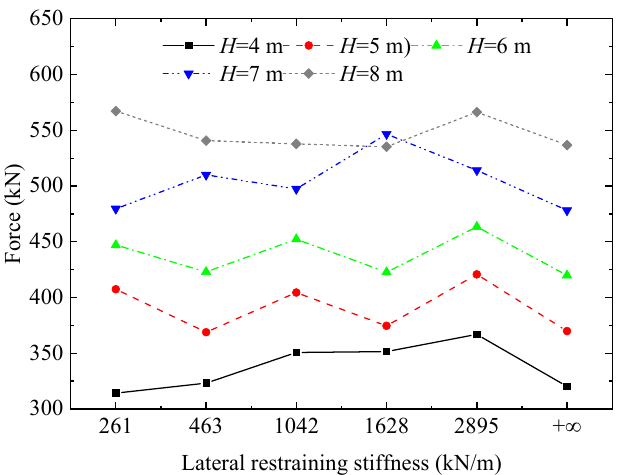
Figure 15. Influence of the lateral restraining stiffnesses on the vertical force for Case E20/Cs (0). The lateral restraining stiffness has a negative impact on the mechanical properties of the box-girder superstructure when the submersion coefficient Cs = 0. Compared with the fixed box-girder superstructure, the flexible box-girder superstructure may lead to an increase in the vertical peak force. It is not conducive to the survival of the box-girder superstructure under extreme waves. It indicates that the setting of lateral restraining stiffness would bring negative effects when the box-girder superstructure is near the water surface. Therefore, during the design and construction of coastal box-girder bridges, it should try to keep the box-girder superstructure away from the water surface in a reasonable range. It can avoid the failure of the flexible mechanism of the box-girder superstructure due to the rise of the sea level. In some inevitable areas (e.g., where the elevation of the bridge is limited), the vertical restraining force of the box-girder superstructure should be strengthened to improve disaster